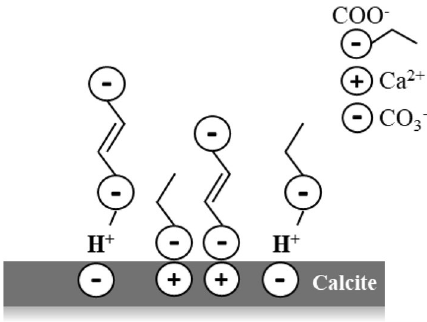
Figure 6. Schematic representation of carboxylic acid chemisorption onto calcite